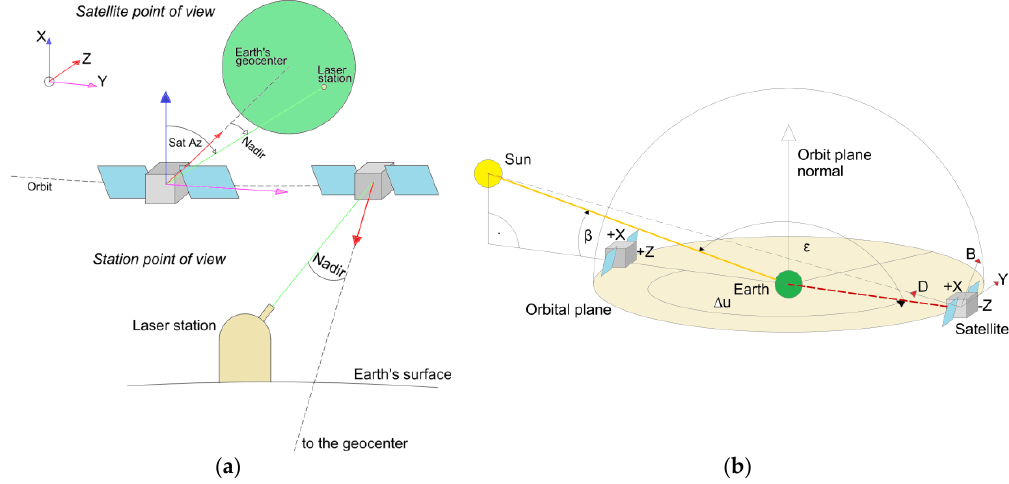
Figure 1. ( a ) Satellite-based reference frame; and ( b ) relative geometry of the Earth, satellite and the Sun showing the elevation angle of the Sun over orbital plane β, argument of the satellite latitude with respect to the Sun Δu and the elongation angle ε.